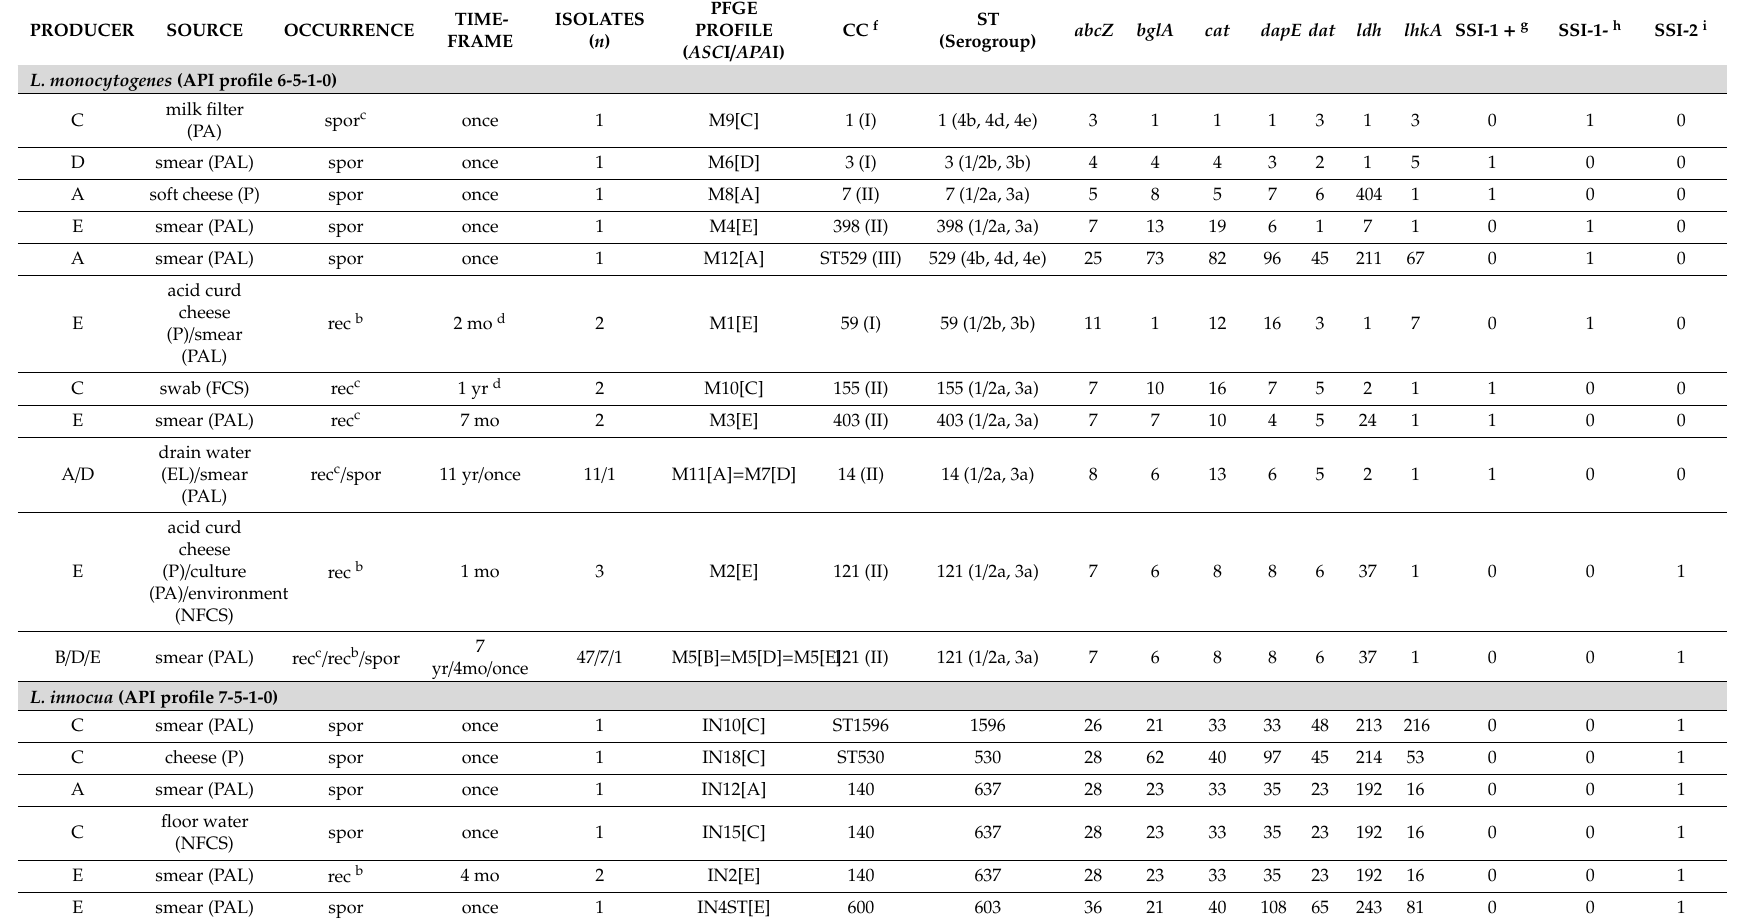
Table 1. L. innocua ( n = 139) and L. monocytogenes ( n = 81) isolate characteristics included in this